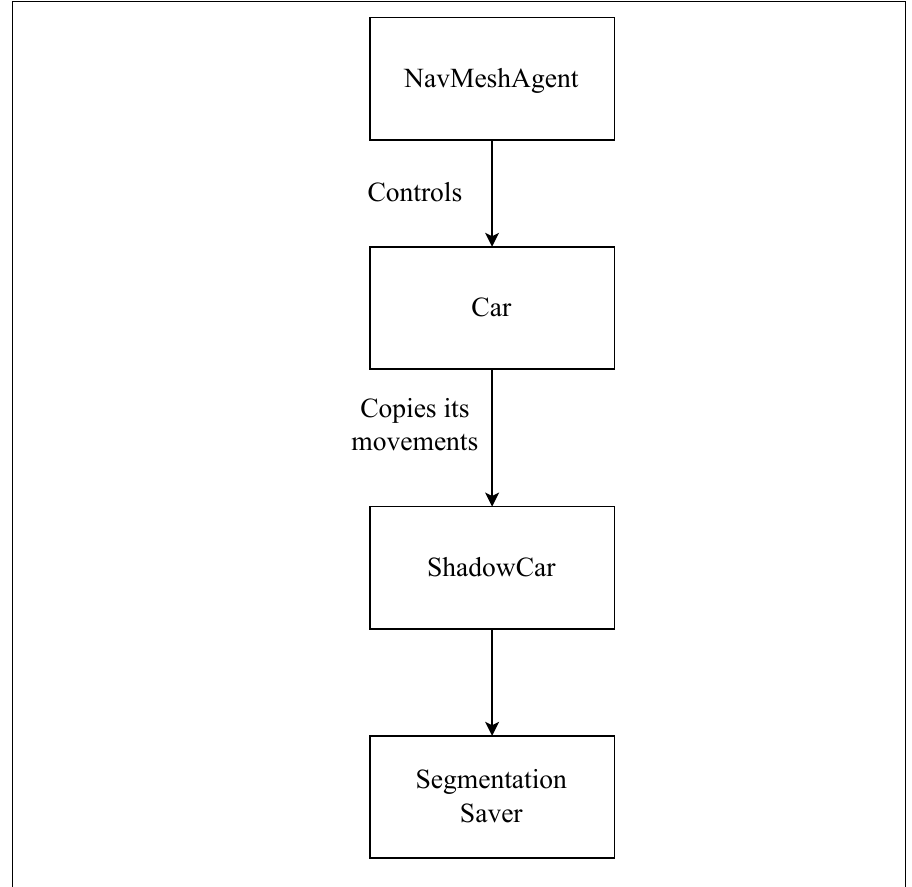
Figure 2. Overview of the modifications for performing segmentation. Figure 3 shows the segmentation photos, the tires which are off the road and the number of times any of them have been off the road, as well as the number of times the vehicle has been in the area. Figure 3a shows the comparison between the RGB and the segmented image while Figure 3b shows the number of actions where the vehicle had any of its tires off the road. The number of actions during which the vehicle was within 5 m is shown in Figure 3c. Figure 3d shows which of the tires are on the road, with the green letters representing tires on the road, and red representing tires off the road. The letters FL refer to the front left tire, while the letters BR represent the back right